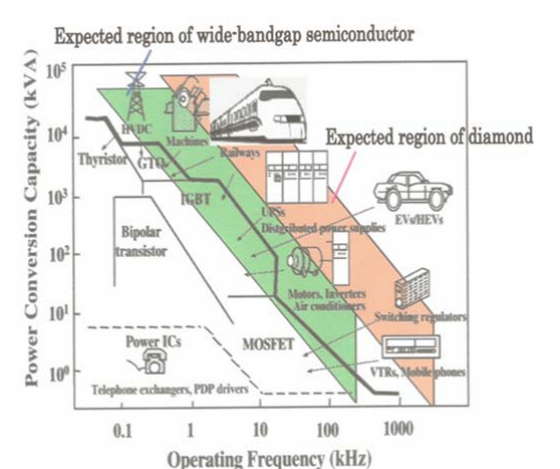
Figure 4. Expected region of wide bandgap semiconductor (after